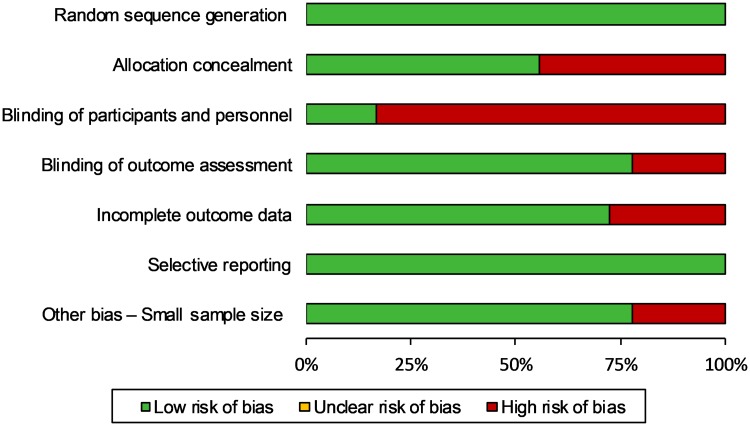
Distribution of risks of bias across studies.